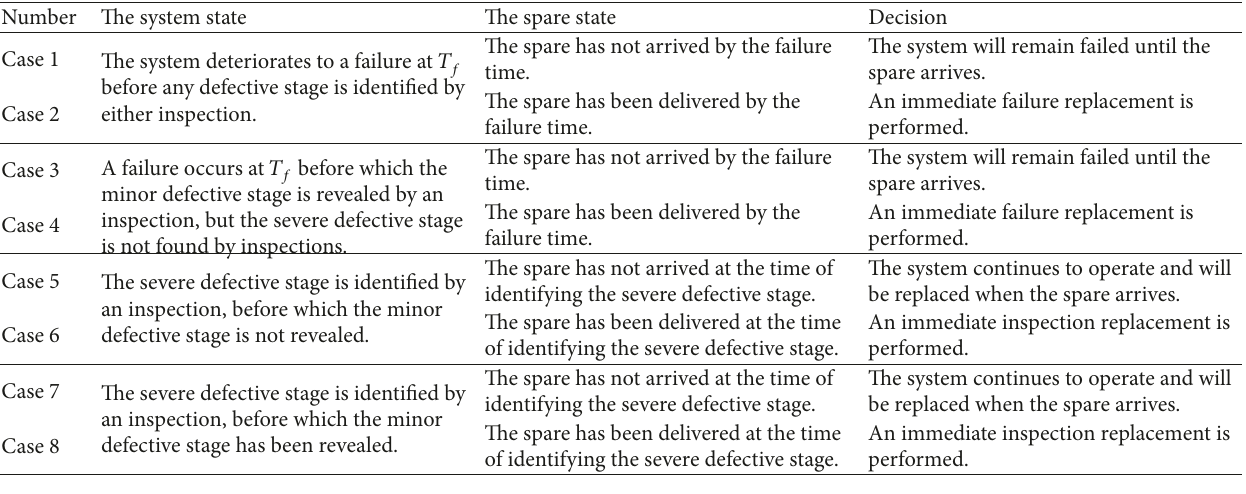
Table 4: All possible cases of model 𝐼𝐼